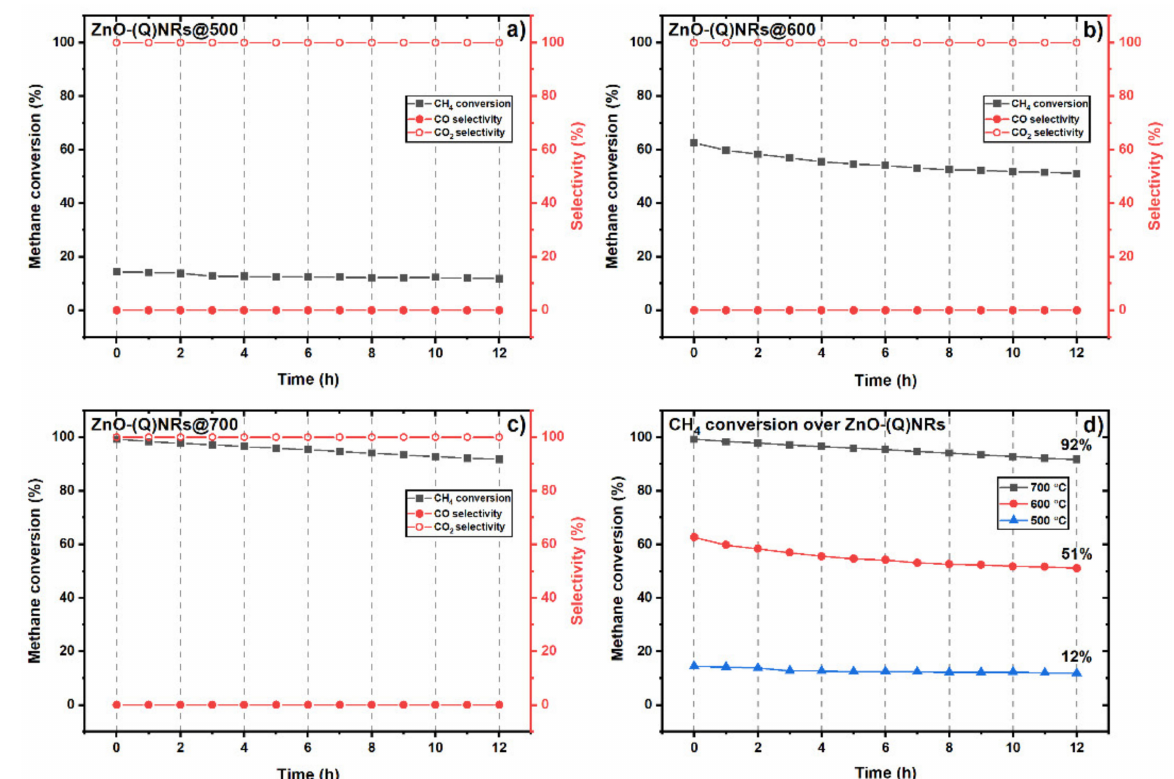
Figure 11. Time-on-stream (TOS) methane conversion (black) and CO and CO 2 selectivity (red) of methane combustion reactions catalyzed by ZnO-(Q)NRs at ( a ) 500 ◦ C, ( b ) 600 ◦ C, ( c ) 700 ◦ C, and ( d ) a comparison of methane conversion at the three temperatures with the conversion values observed after 12 h shown as